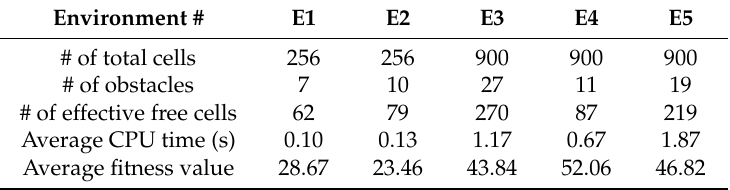
Table 7. Comparison of experimental spaces and results between each